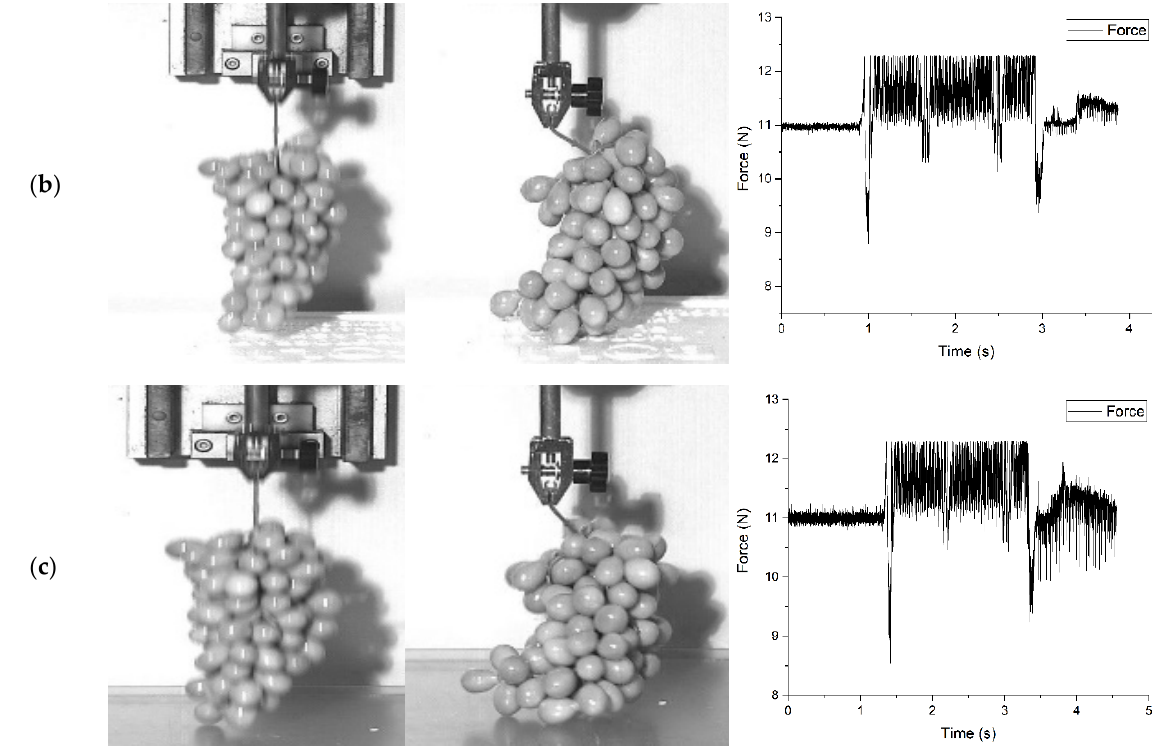
Figure 9. High-speed camera-based determination of cluster deflection and force signals after striking with different placing materials: ( a )force change signals with corrugated fiberboard; ( b ) force change signals with expandable polystyrene; ( c ) force change signals with a rigid plastic box.